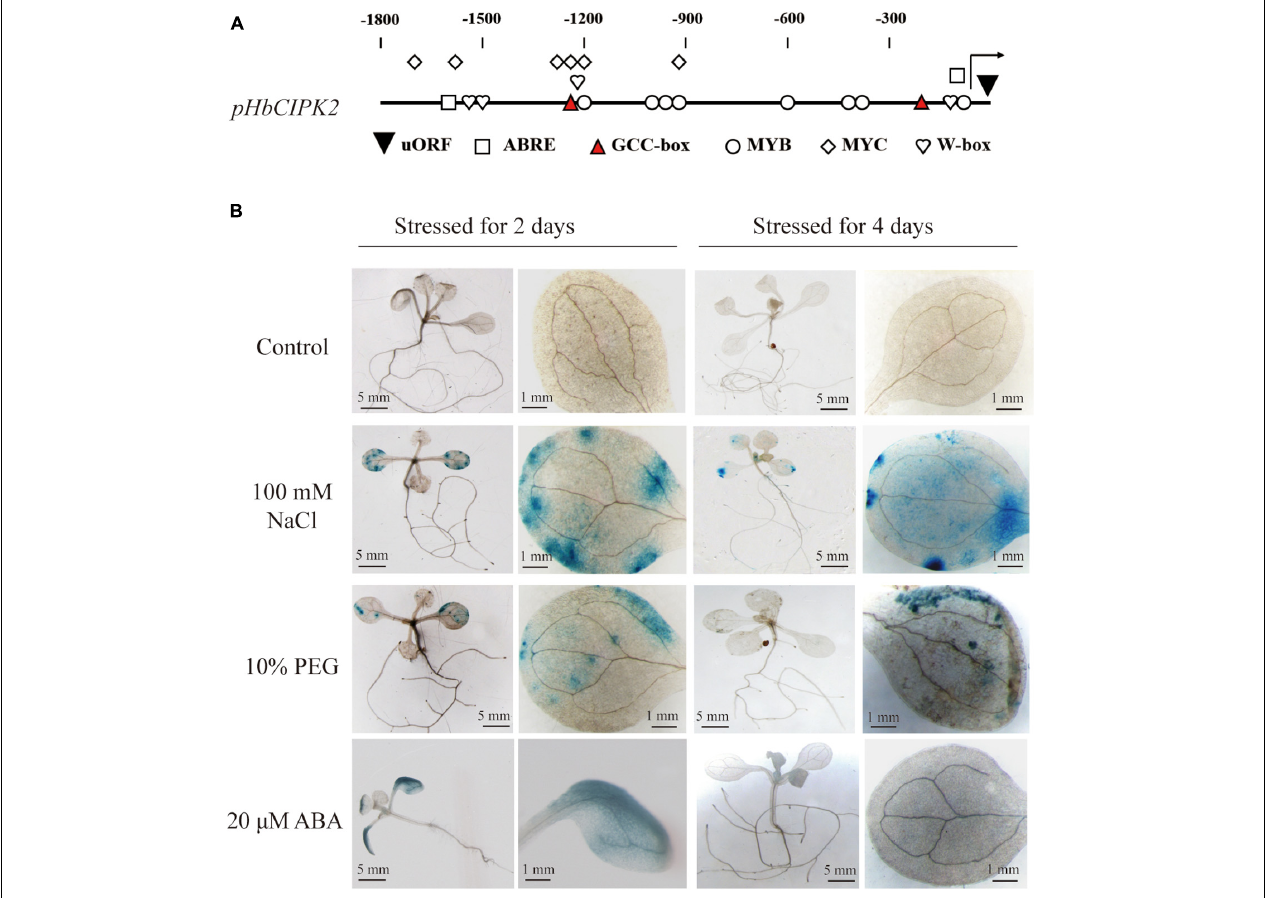
FIGURE 1 | The activity of HbCIPK2 promoter was induced under different stresses. (A) Structural diagram of HbCIPK2 promoter, HbCIPK2 promoter contains two GCC-boxes (box-1, –1086 to –1080; box-2, –232 to –226). Different components are represented by different icons. GCC boxes are denoted via triangles. (B) Histochemical staining of transgenic Arabidopsis lines under control and various stress conditions at different times. Scale bars are marked in the figures.